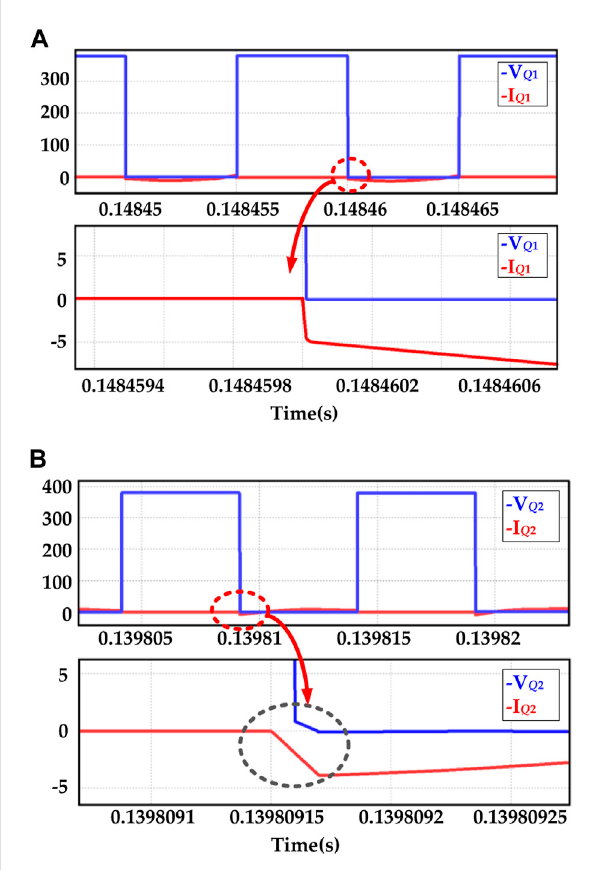
FIGURE 11 Current waveform and voltage waveform. (A) is the waveform of Q 1 in the optimized circuit; (B) is the waveform of